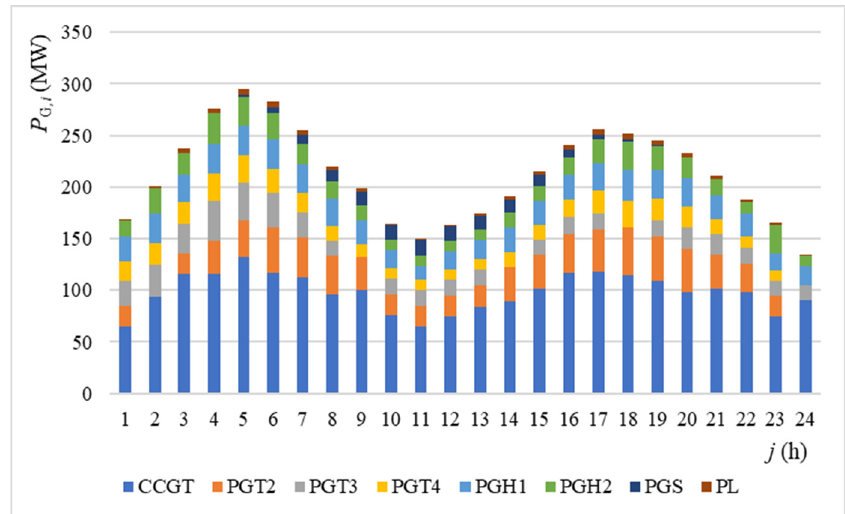
Figure 10. Optimal generation scheduling for case 1–sub-case 2.